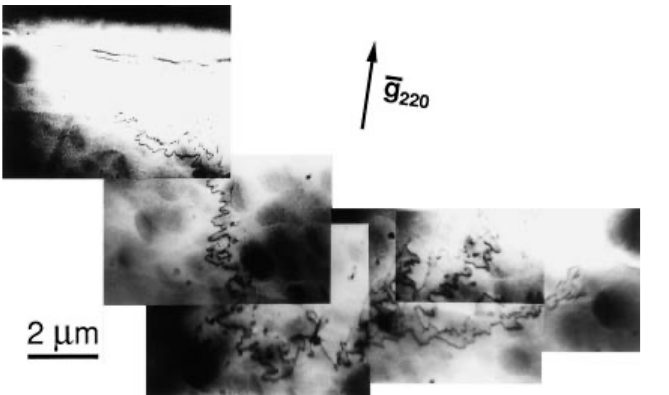
Figure 2. TEM image of dislocation dipole associated with <1 0 0> direction DLD in a rapidly degraded GaAlAs/GaAs double-heterojunction laser [25]. Reprinted with permission from ref. [25] © Elsevier. Copyright 1999 Microelectronics Reliability.